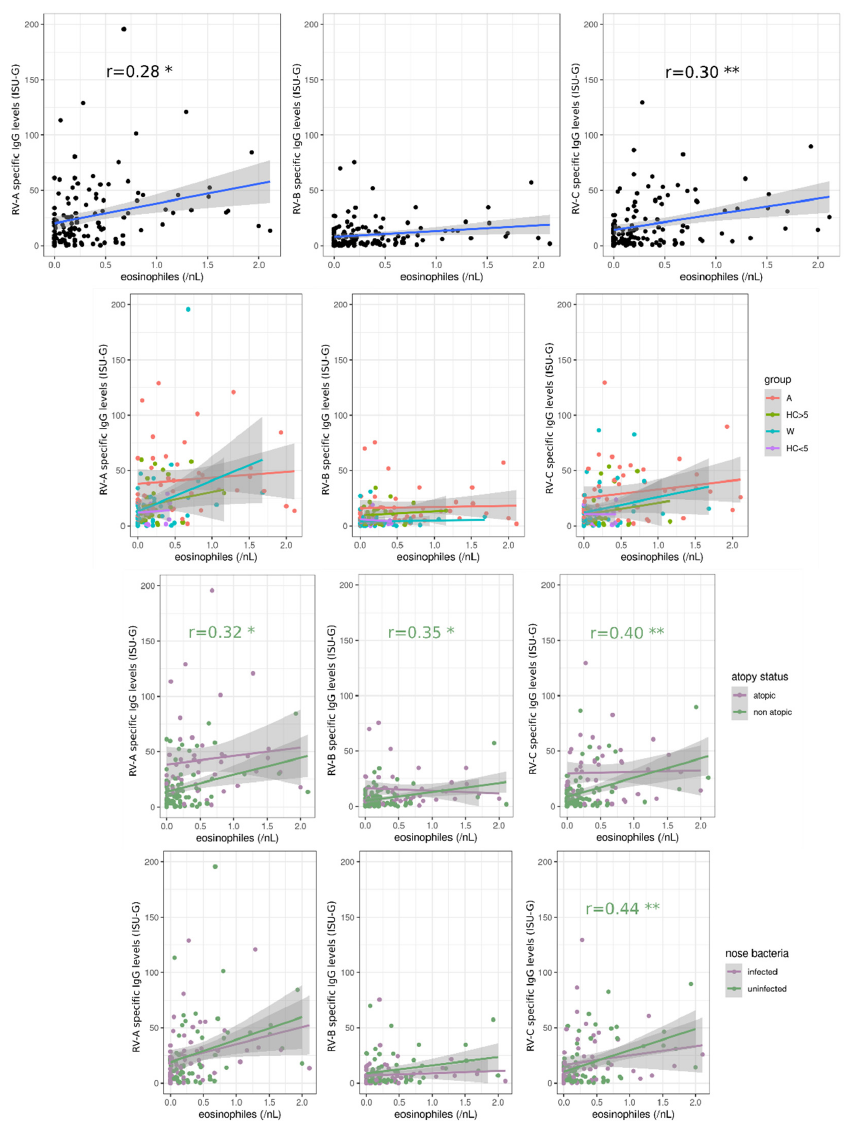
Figure 5. Blood eosinophils are positively correlated with Rhinovirus (RV)-specific IgG levels. For each RV species, the correlation between virus-specific IgG levels and blood eosinophils titer was tested using Pearson’s linear correlation tests, with either group, atopy status, nose bacteria infection status, or no stratification. The correlation coefficient ρ values are shown in the graphs. All p -values were corrected using the FDR method. *: 0.01 < p < 0.05; **: 0.001 < p < 0.01. A: Asthmatics, HC > 5: Healthy controls five years old or older, W: Wheezers, HC < 5: Healthy controls younger than five years